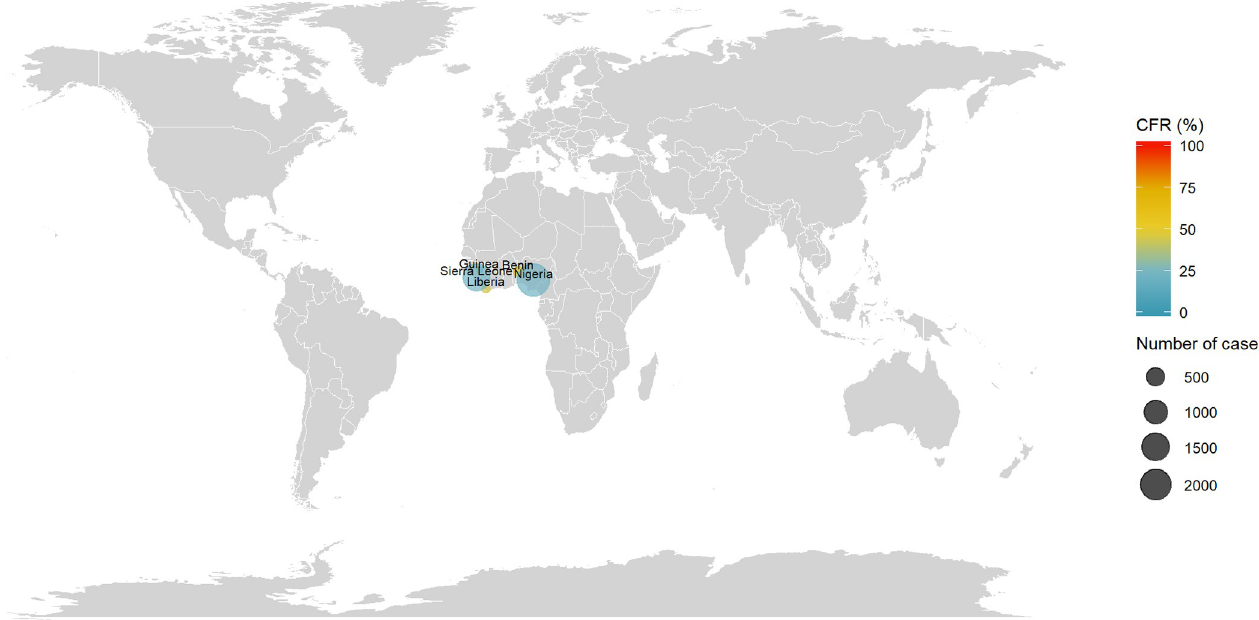
Fig 6. Distribution of number of cases and CFR of Lassa fever. The size of the bubble is proportional with the number of cases reported and the color denotes the level of CFR by country. Note: Maps were generated with the ‘maps’ R package using data from the Natural Earth Project (the 1:50m resolution